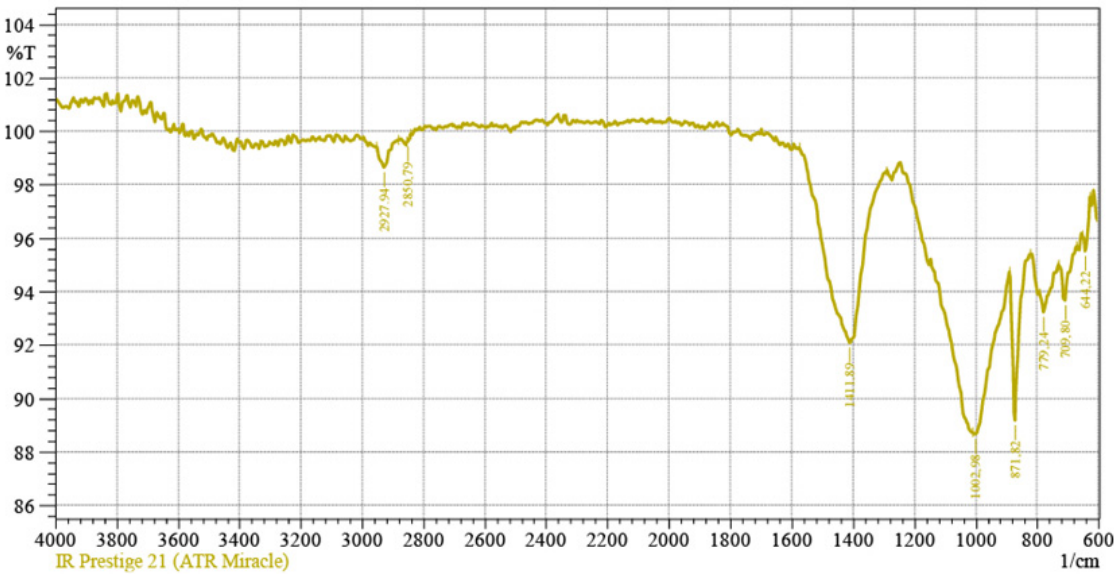
Figure 8. Diffraction patterns of the AAM based on thermally treated (700 °C) marl (sample TM1), in comparison with the database PDF-2. The comparison phases are as follows: A—quartz, B—cal-